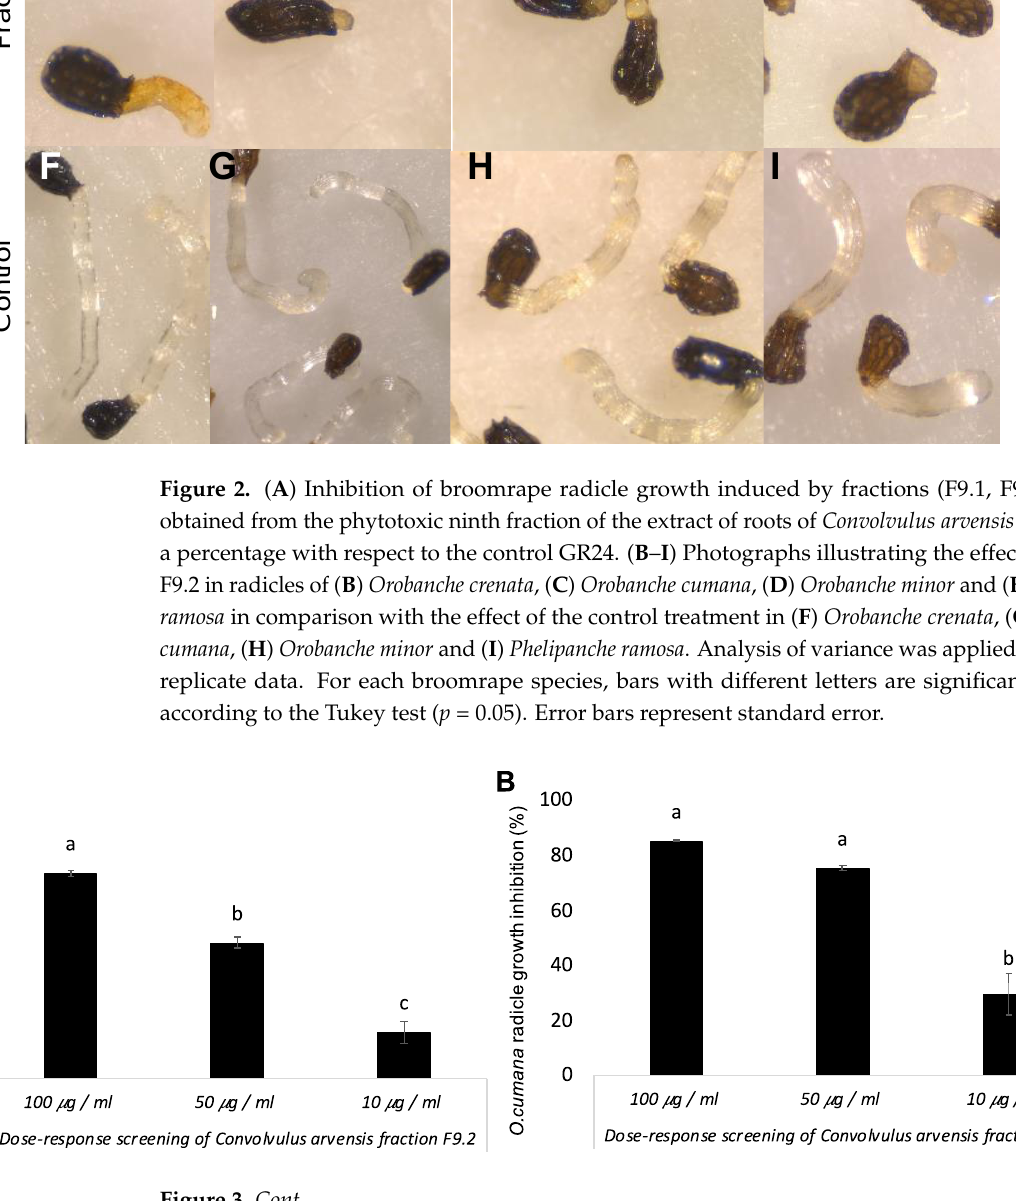
Figure 3. Dose – response curve of the phytotoxic activity of Convolvulus arvensis fraction F9.2 on radicle growth expressed as a percentage with respect to the growth of radicles treated with control treatment GR24 of ( A ) Orobanche crenata , ( B ) Orobanche cumana , ( C ) Orobanche minor and ( D ) Pheli- panche ramosa . Analysis of variance was applied to transform replicate data. For each broomrape species, bars with different letters are significantly different according to the Tukey test ( p = 0.05). Error bars represent standard error. The first investigation of the 1 H NMR and ESI MS spectra on fraction F9.2 showed that it contains arvensic acids by comparing the data with those reported in the literature [24 – 26]. In particular, the 1 H NMR spectrum showed the signals of anomeric protons at δ 6.3 – 4.6 ppm, the complex signals in the range of δ 4.3 – 3.2 ppm typical of hydroxylated ring protons and singlets at δ 1.2 ppm for 6-deoxy sugar residues. Furthermore, aliphatic signals diagnostic of fatty acids in the range of δ 2.8 – 1.8 ppm were observed. The ESI-MS spectra of these mixtures showed peaks in the range 1074 – 1380 u.m.a., confirming the hypothesis of a mixture of arvensic acids. They have a polysaccharide skeleton containing rhamnose, fucose and glucose residues linked to hydroxyl or dihydroxyl fatty acids. Pol- ysaccharides' moieties vary from one arvensic acid to another depending on the number and the nature of their monosaccharides. Thus, in order to investigate the monosaccharide composition, fraction F9.2 was hydrolyzed, as reported in the Materials and Methods sec- tion. Afterwards, extraction with the EtOAc of the hydrolyzed solution allowed us to sep- arate the aglycones from the sugar part of the molecules. The aglycone was subjected to a reaction with diazomethane, and the presence of fatty acids was confirmed by TLC, which showed a more apolar compounds with respect to the starting ones. In addition, the 1 H NMR spectrum (Figure 4) showed the presence of methoxy signals indicating the for- mation of the methyl esters. Furthermore, in order to identify the monosaccharide resi- dues of the polysaccharide skeleton, the dried hydrolyzed residue was dissolved in